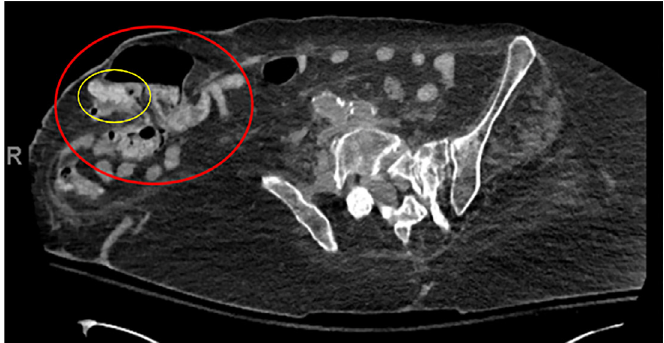
Image 3. Computed tomography (CT) angiography of the abdomen and pelvis. This scan was performed hours after the CT (Image 2). It was found that inside the parastomal hernia (large red circle), contrast had appeared in this hernia, which was not previously visible on prior CT (circled